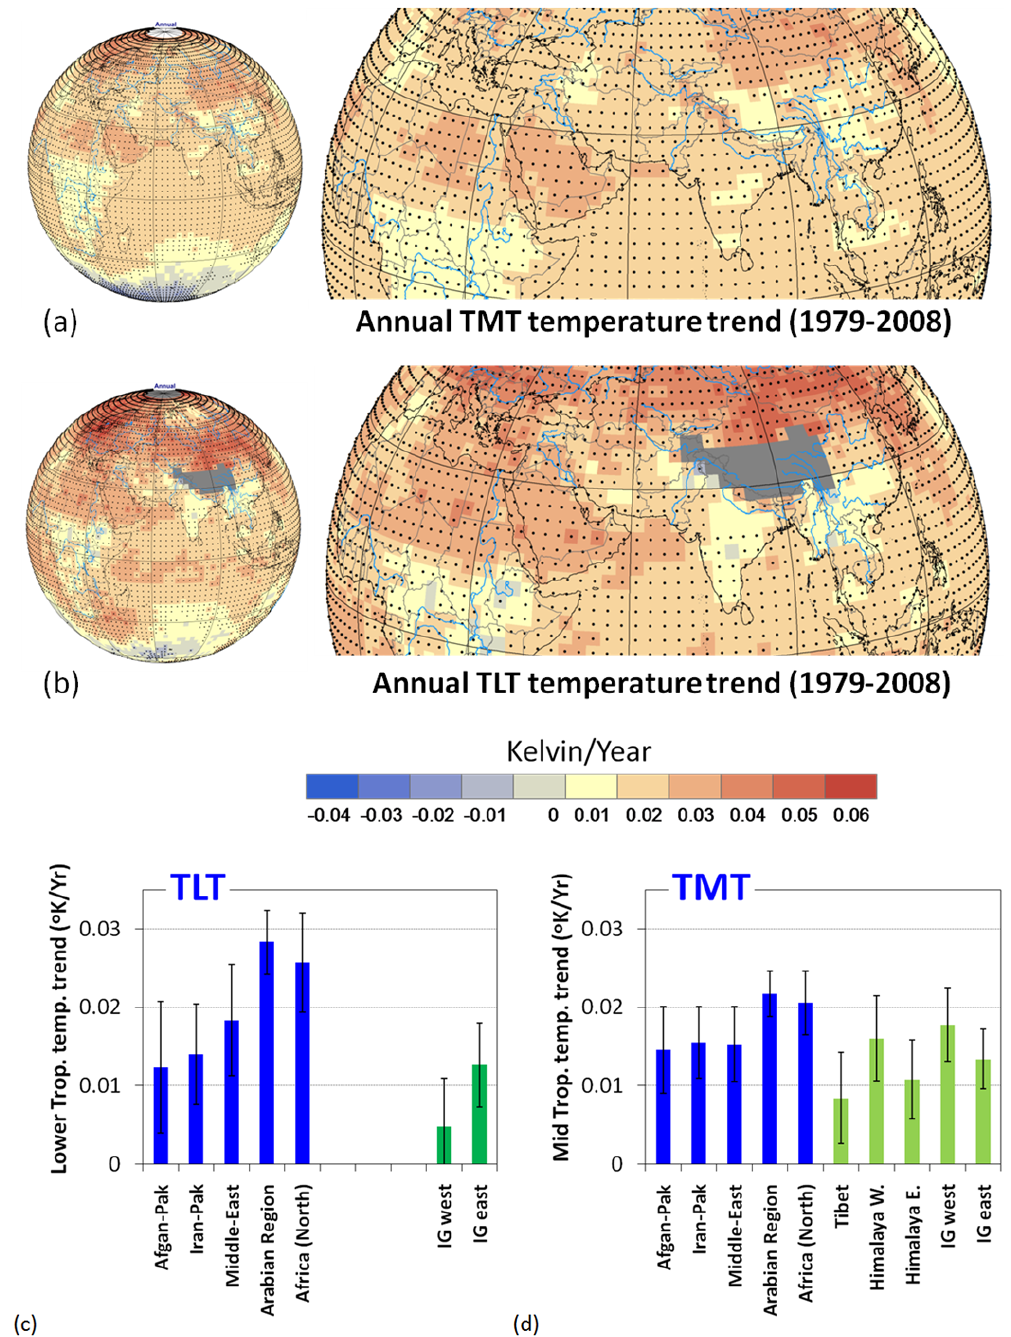
Fig. 2. The annual linear trend ( ◦ Kelvin/year) of brightness temperature based on 30 years (1979–2008) of MSU (a) TMT (mid-troposphere) and (b) TLT (lower troposphere) anomaly data. Mean annual tropospheric temperature trend with standard error ( ◦ Kelvin/year) for (c) lower troposphere, and (d) mid-troposphere over different study regions. The black dot at the center of any box (a, b) represent that the calculated linear trend value is statistically significant at alpha 0.05 (95%